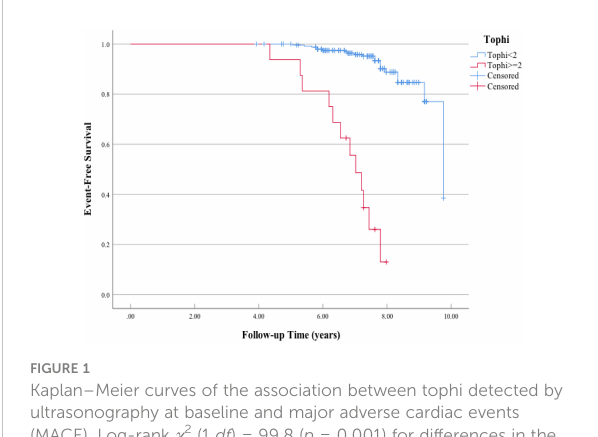
FIGURE 2 Kaplan – Meier curves of the association between carotid plaque and major adverse cardiac events (MACE). Log-rank c 2 (1 df ) = 36.7 ( p = 0.001) for differences in the event-free survival rate between patients who had positive carotid plaque and those who had negative carotid